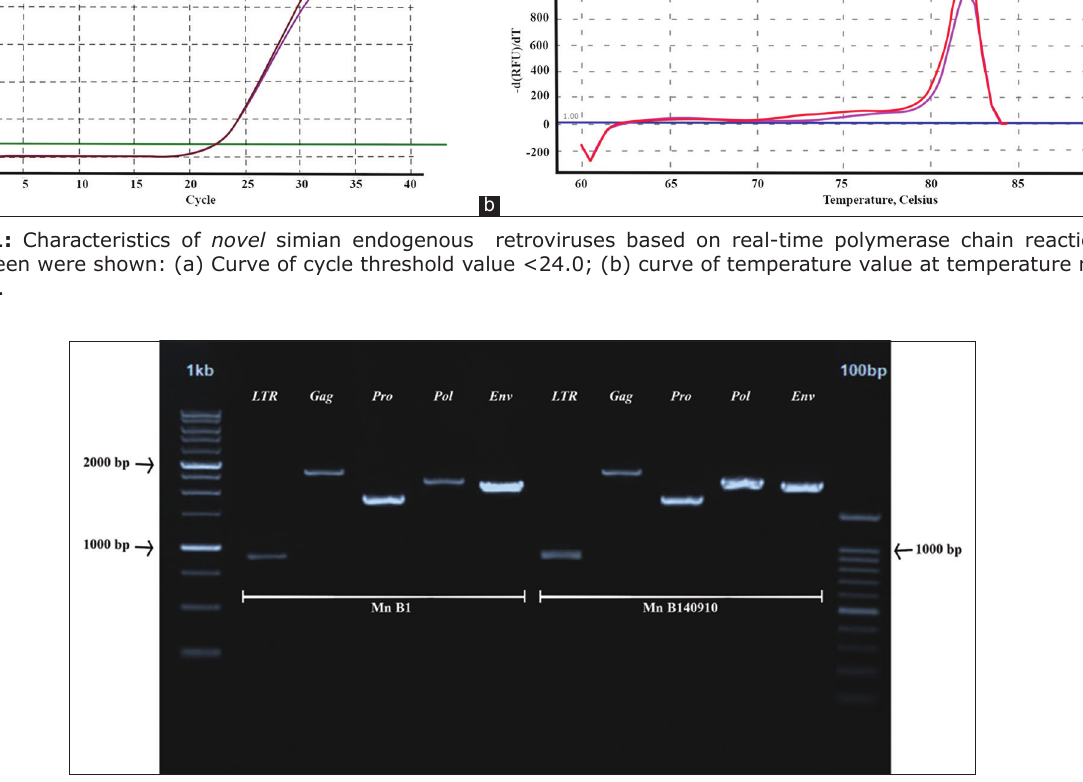
Figure-2: DNA visualization of simian endogenous retroviruses whole genome for target genes long terminal repeat (879 bp), gag (1928 bp), pro (1729 bp), pol (2243 bp), and env (2097 bp) in 1% agarose gel. 1 kb and 100 bp: DNA ladder.